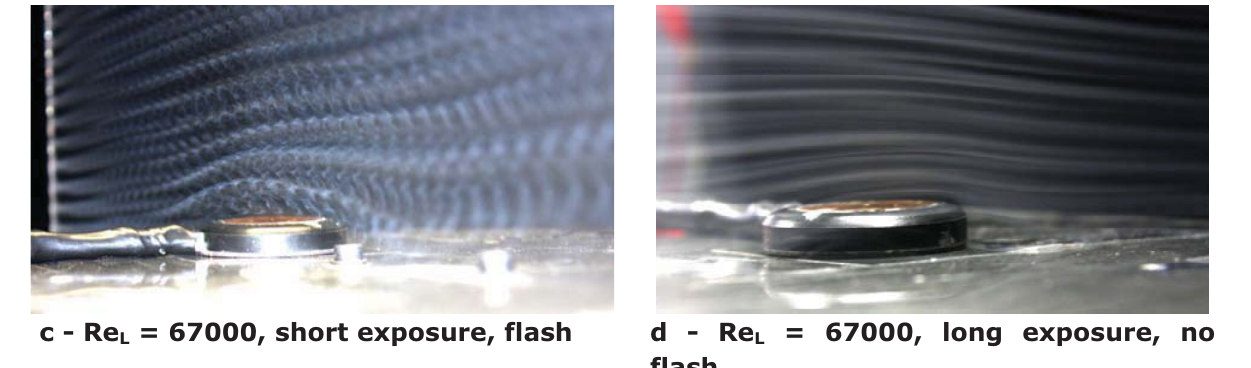
= 67000, without flash, long exposure L